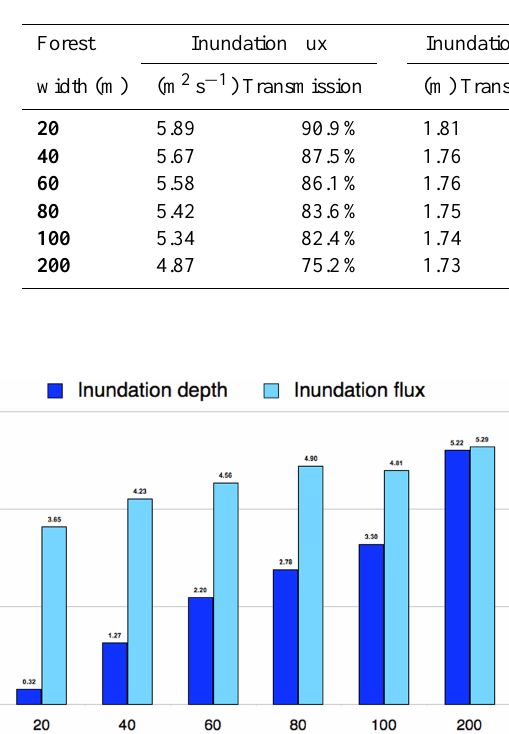
Table 4. The forest widths and the transmission Forest width (m)